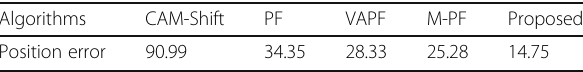
Table 4 Resulting of averaged position error of all test videos Algorithms CAM-Shift PF VAPF M-PF Proposed Position